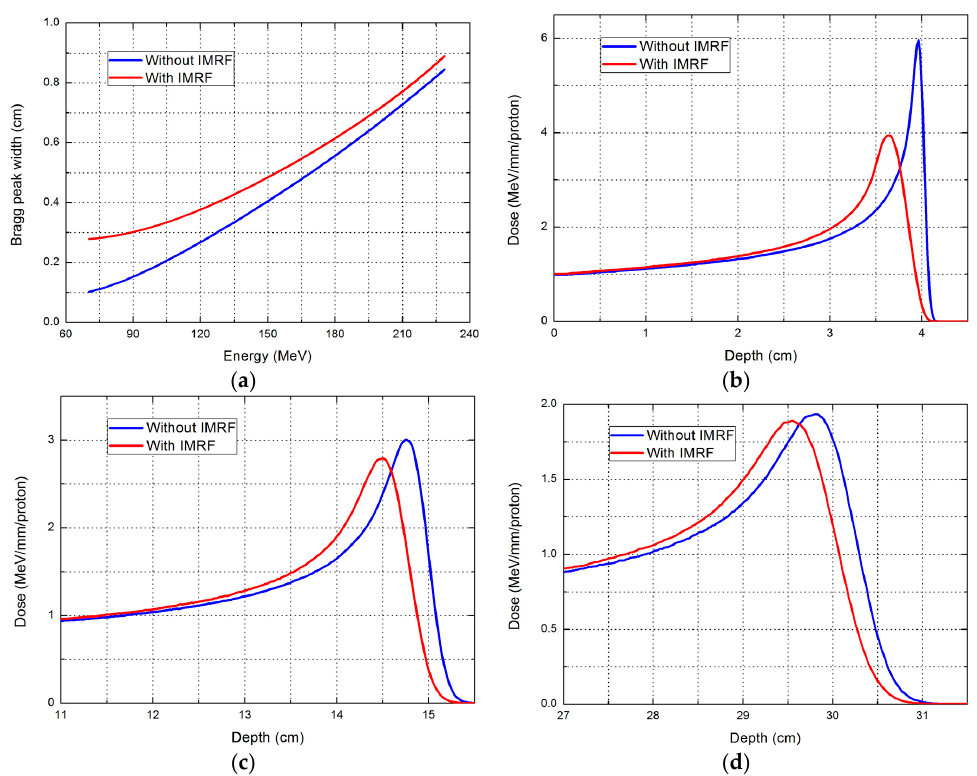
Figure 1. Bragg peak width (defined at 80% the peak) and integral depth dose for plans with and without integrated mini-ridge filter (IMRF). ( a ) Bragg peak width; ( b ) range = 4 cm; ( c ) range = 15 cm; ( d ) range = 30 cm.